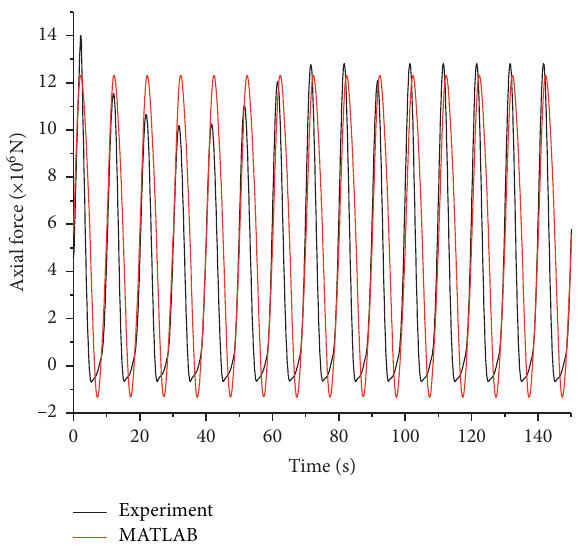
Figure 17: Comparison of experiment and